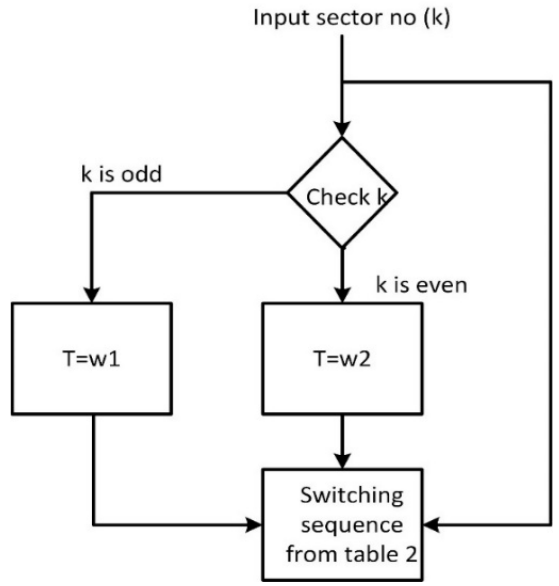
Figure 4. Algorithm to calculate dwell time and switching sequence in different sectors using NSV-SVPWM.